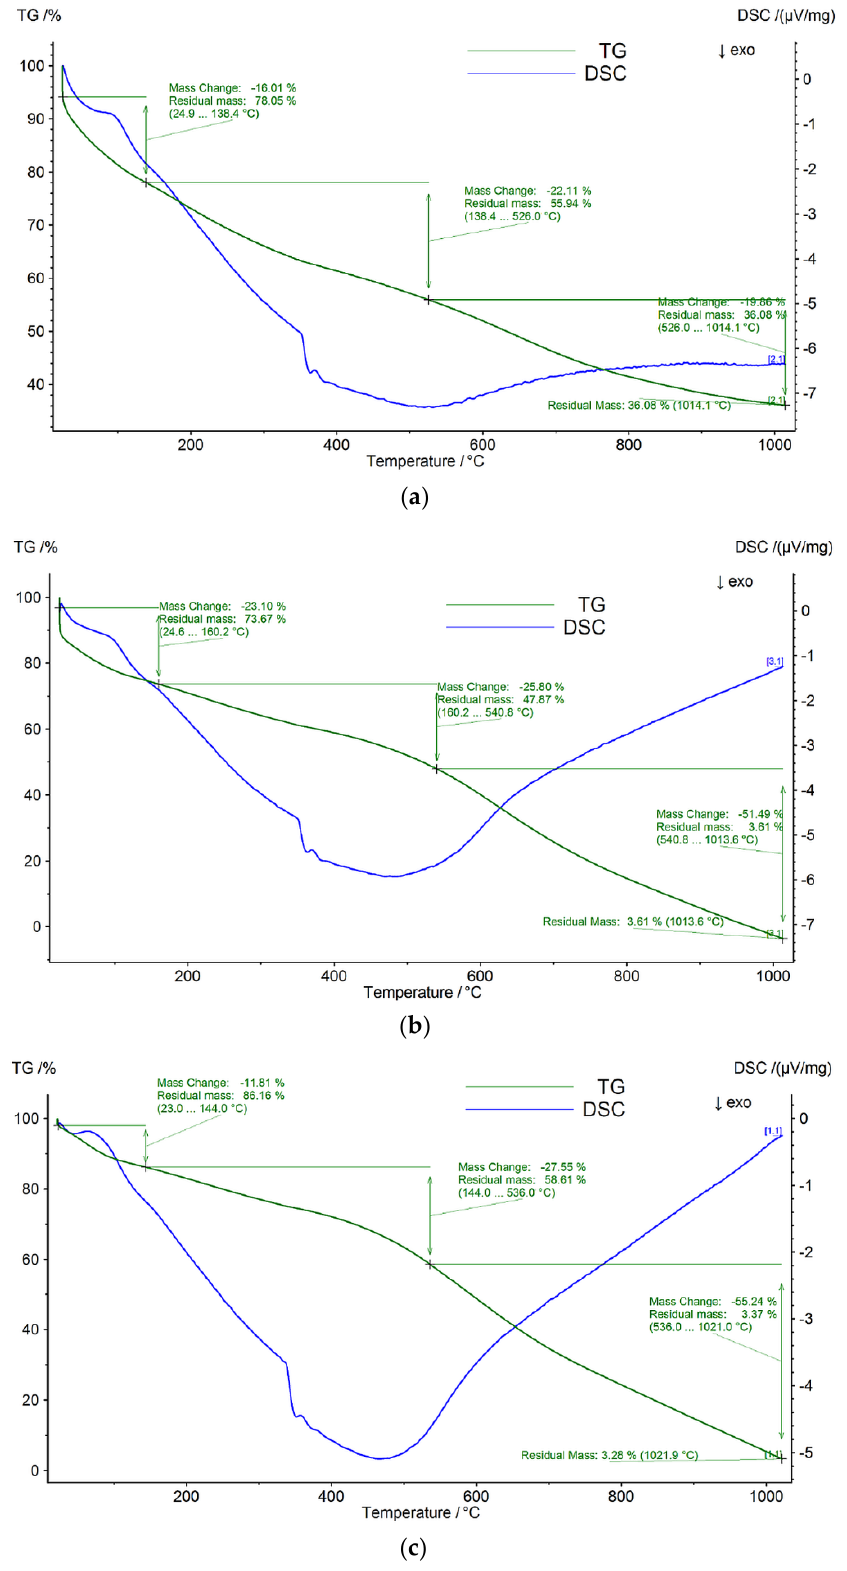
Figure 10. Thermogravimetric analysis (TGA) and differential scanning calorimetry (DSC) measurements of nitrogen-doped graphene oxides. ( a ) TGA and DSC curves corresponding to N/GO_A. ( b ) TGA and DSC curves corresponding to N/GO_U. ( c ) TGA and DSC curves corresponding to N/GO_N.